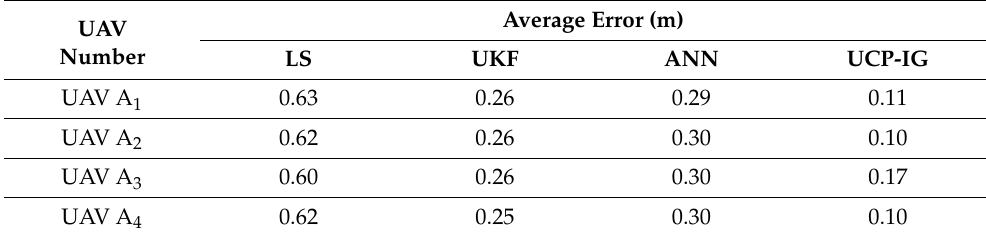
Table 3. Average positioning errors (comprehensive